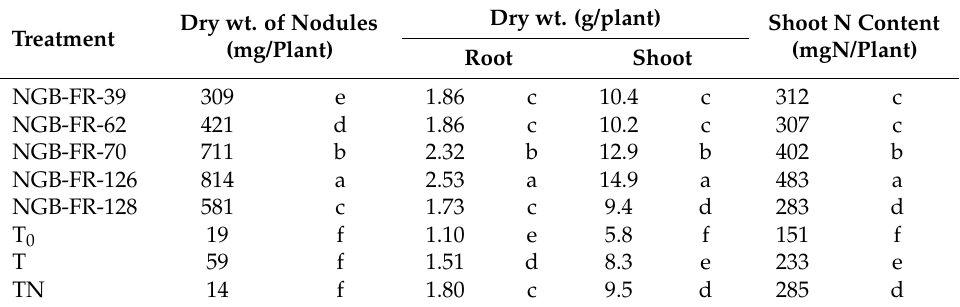
T: uninoculated seeds plus starter N-fertilizer (48 kg N · ha − 1 ). TN: uninoculated seeds and full N-fertilizer (96 kg N · ha − 1